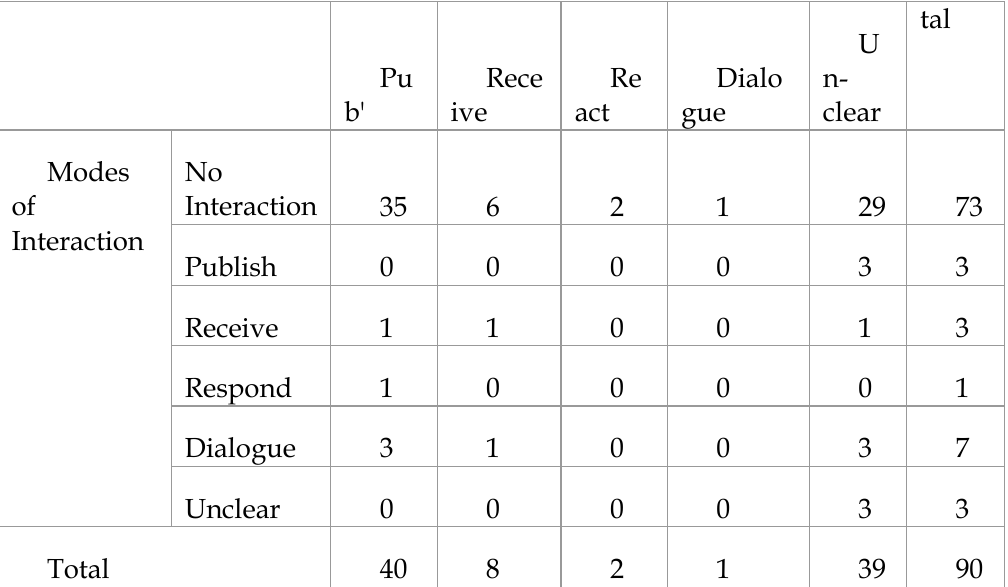
None Explicit dependence